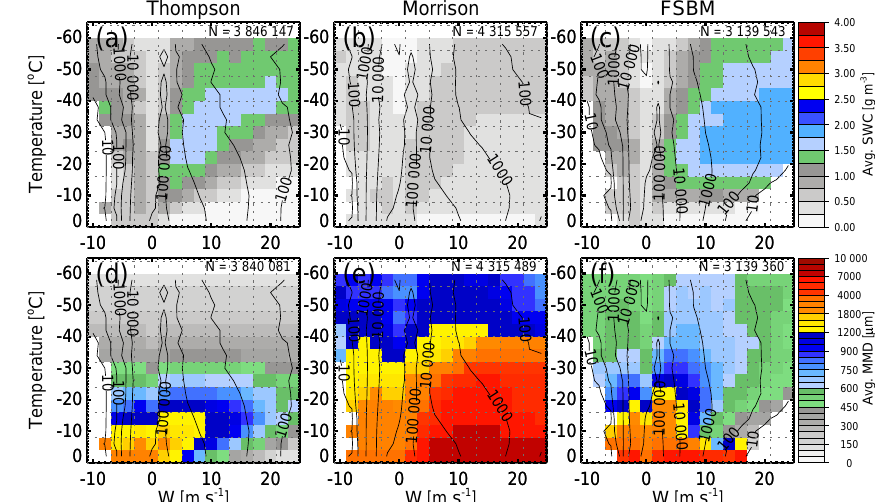
Figure 12. As in Fig. 11, but for snow water content (SWC) color-filled in (a) – (c) and average snow MMDs color-filled in (d) – (f) .